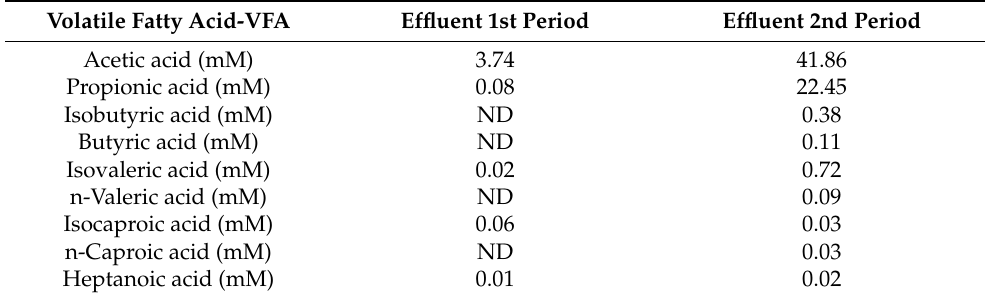
Table 4. Volatile Fatty Acids (VFAs) concentrations of the biogas plant’s effluent from the 1st and 2nd period.